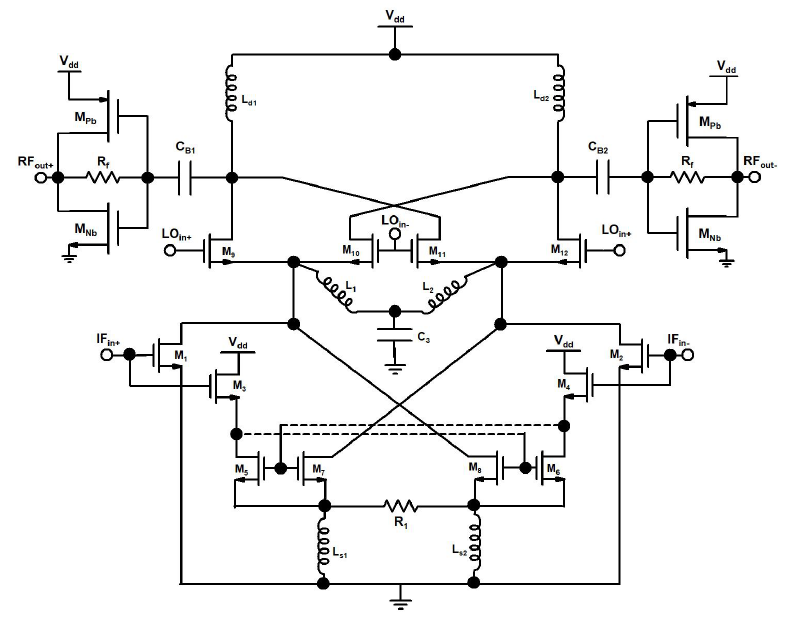
Figure 4. Proposed up-conversion